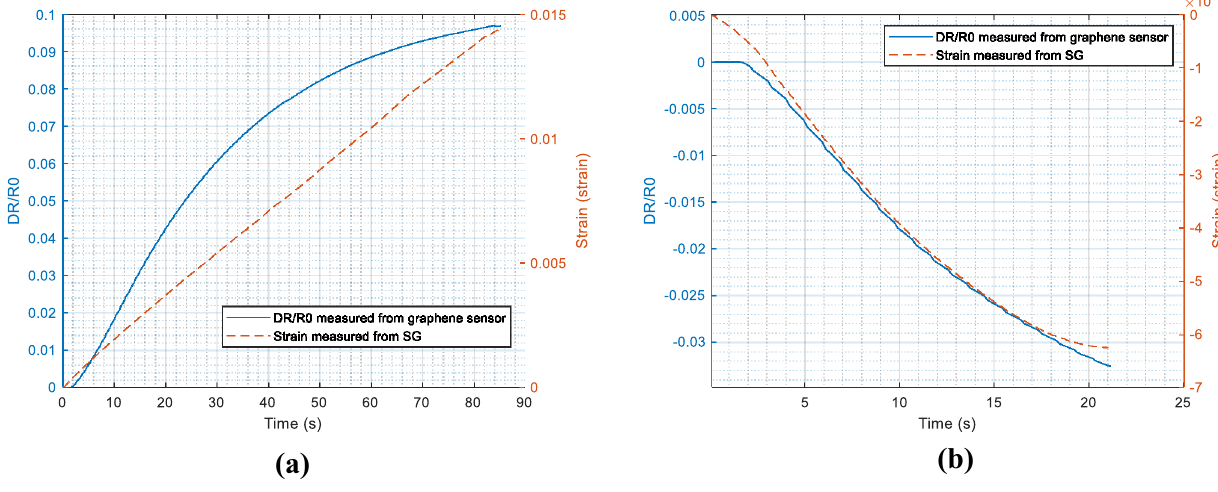
Fig. 14 Resistance change comparison for the graphene-based strain sensor to strain measurement obtained from strain gauge under a normal tensile load and b normal compression load applied on a GFRP coupon with an embedded graphene sensor for strain measurement